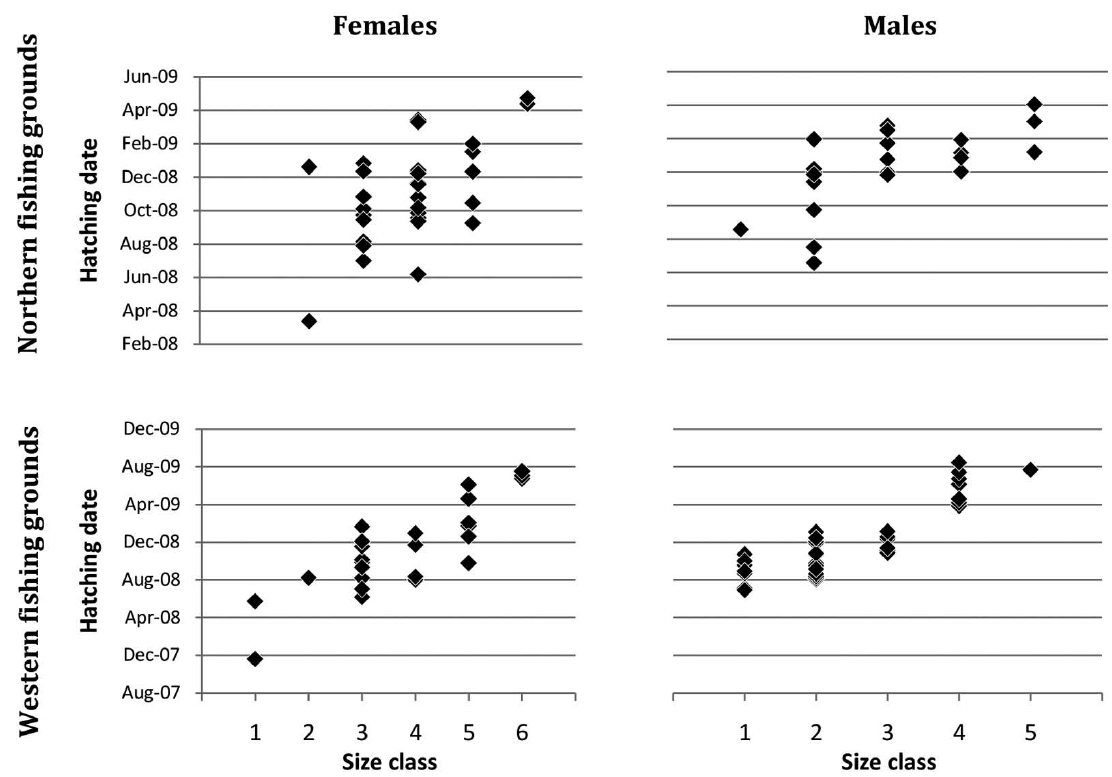
Fig. 7. – The figure illustrates the application of MPA as a proxy for defining age classes in Eledone cirrhosa . Specimens of each sex and fishing ground are displayed separately according to their estimated hatching date and the size class they belong to. Size classes were previ- ously defined by MPA and followed in time, so specimens of a particular size class would be expected to have hatched at about the same date. Nevertheless, the range of hatching dates of the specimens belonging to consecutive size classes largely overlap in many cases.